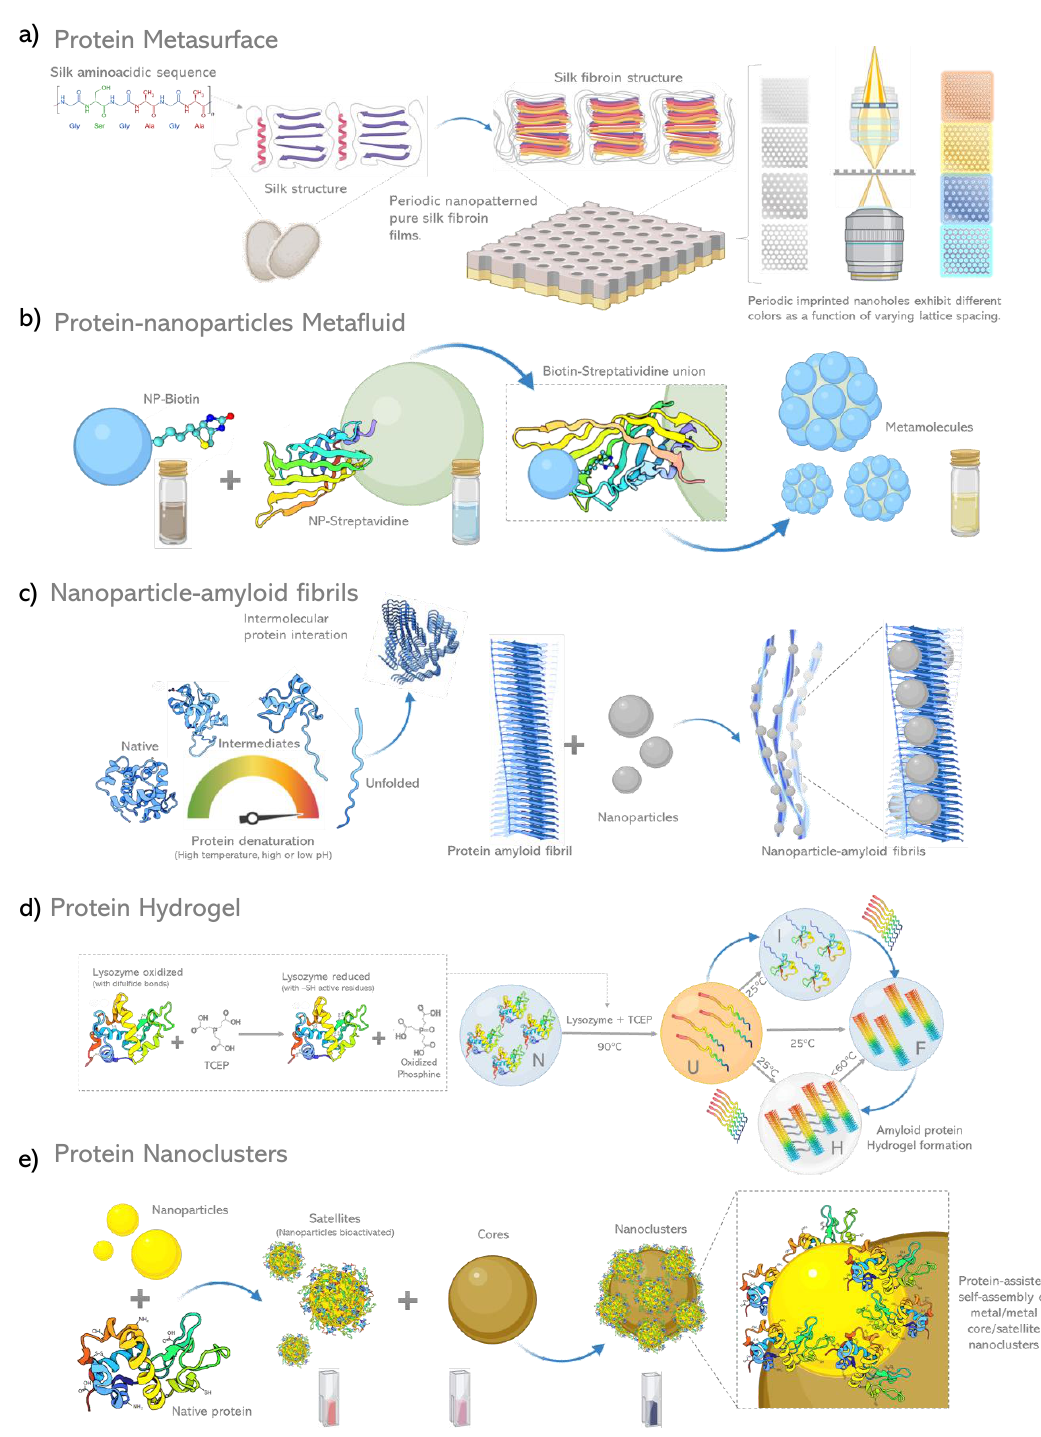
Figure 3. Schematic diagram of protein based metamaterials. ( a ) Protein films of silk